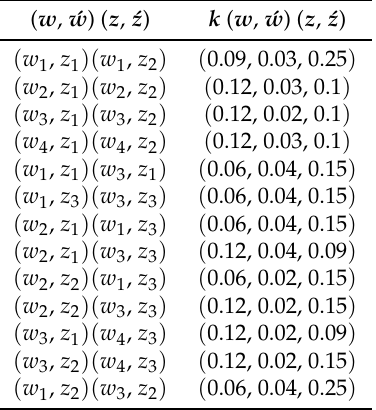
Table 5. Adjacent edges of G C